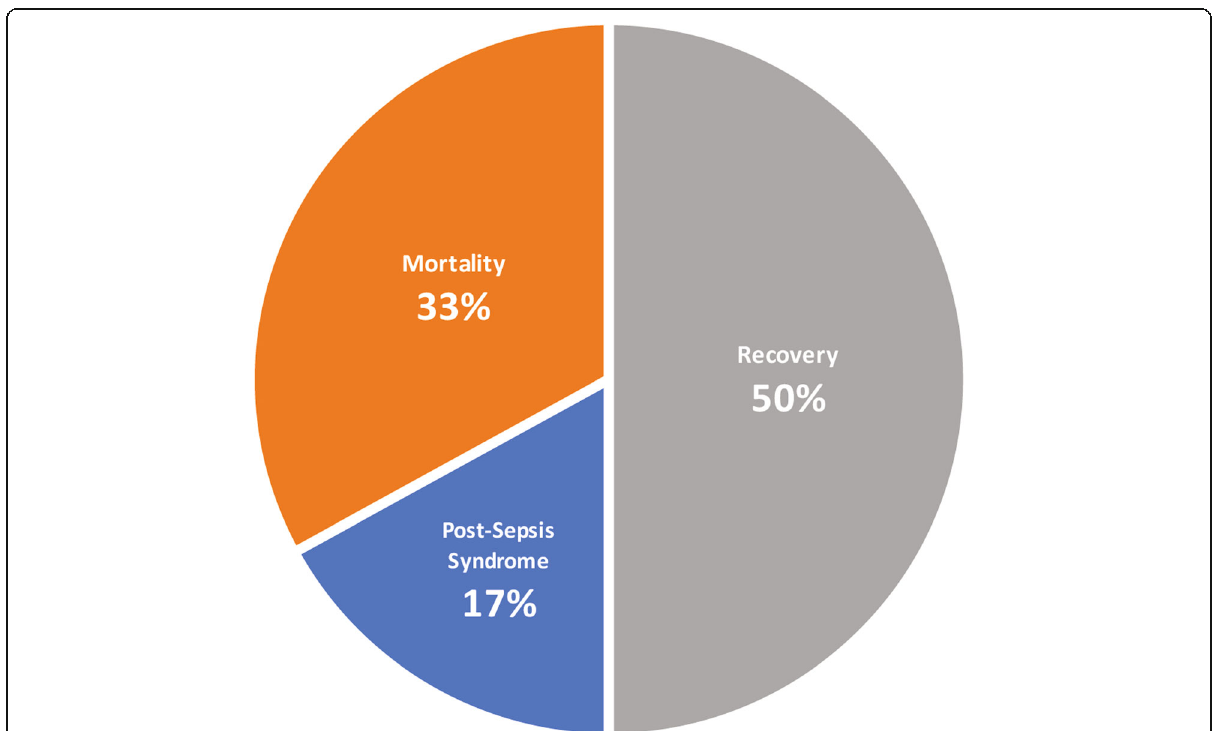
Fig. 3 Patient outcomes following sepsis. Original figure. Approximately half of patients who survived a hospitalization for sepsis achieved a complete or near complete recovery at 2 years after discharge; one third of total patients died during this period; and one sixth of these patients remained with one or more of the serious, lasting complications of post-sepsis syndrome